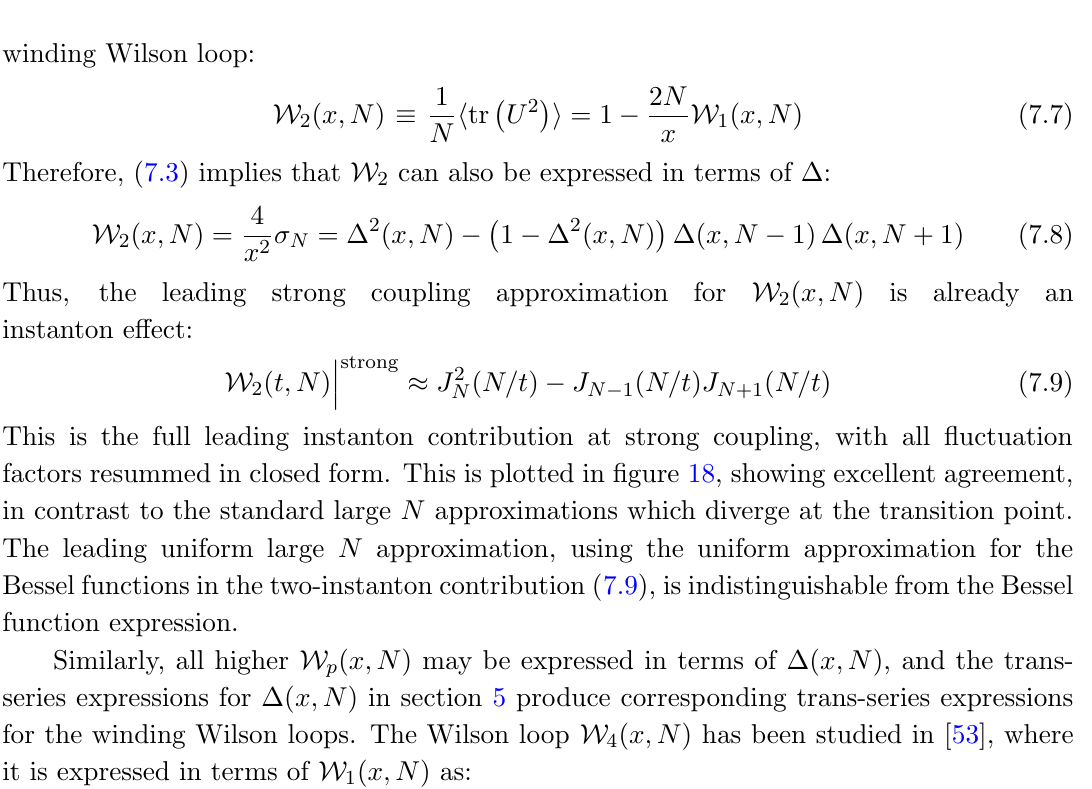
Figure 18 . The solid blue curve shows the Wilson loop W 2 ( t; N ) as a function of ’t Hooft coupling t , with N = 5. The red solid curve is the leading strong coupling approximation in (7.4), for which the uniform strong coupling approximation is indistinguishable. The grey and black dashed lines show the leading terms of the conventional large N approximations for the weak and strong coupling regimes, respectively. Note that the conventional large N approximations diverge at t = 1, while the uniform approximation is smooth and in excellent agreement with the exact result, even at this small value of N